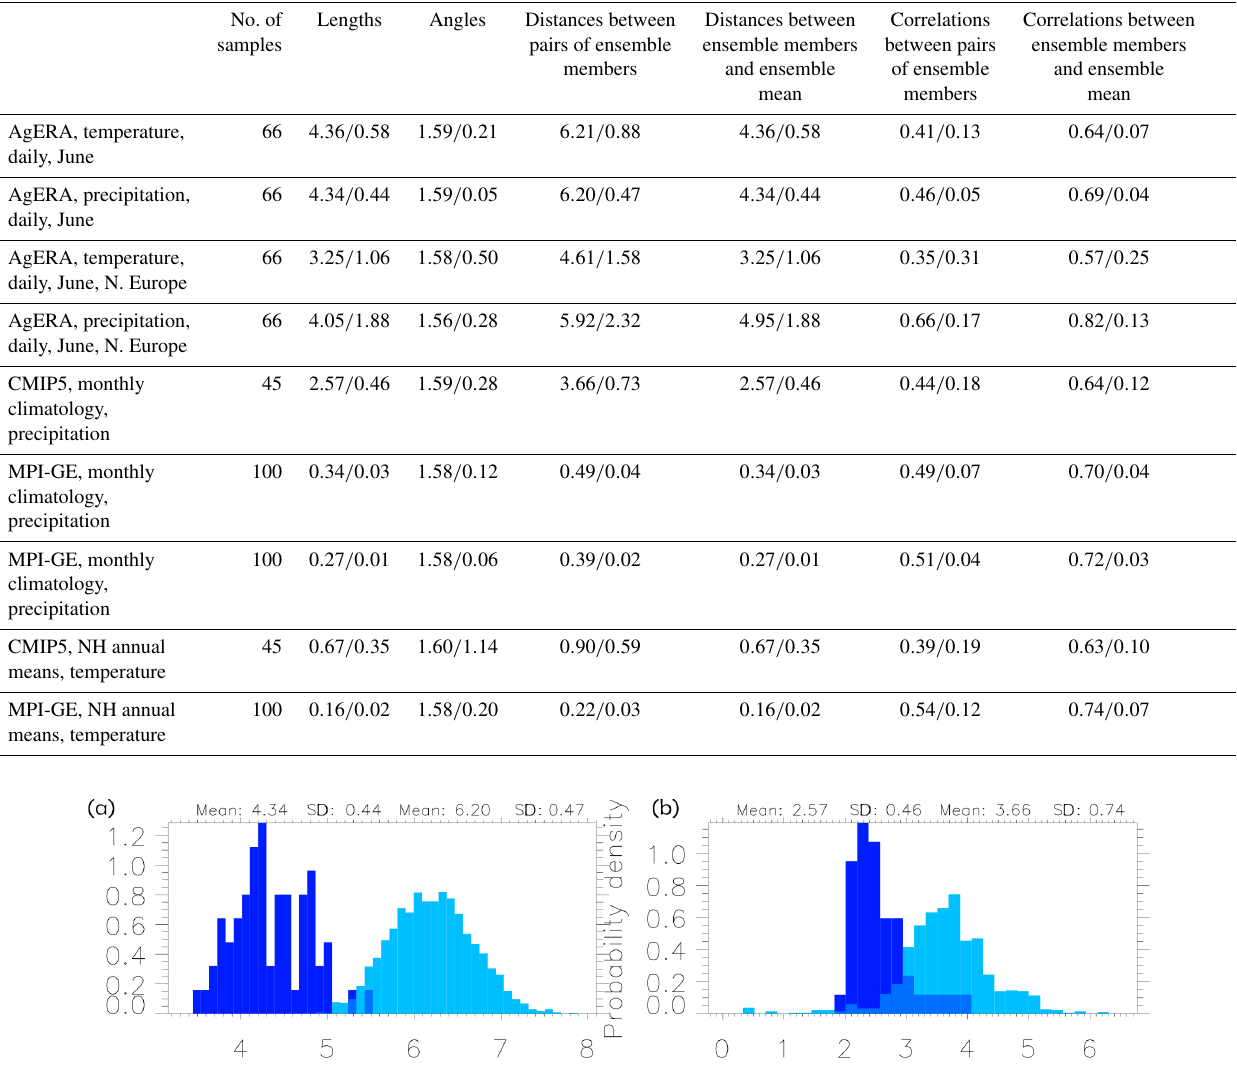
Figure 5. Distances between samples (cyan) and between sample and sample mean (blue). (a) AgERA, daily mean precipitation for June. (b) CMIP5, monthly climatology of near-surface temperature. Note the factor of